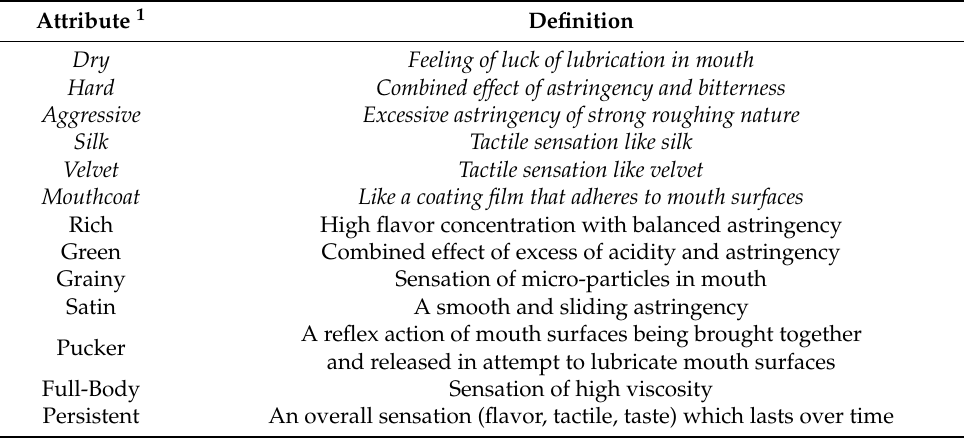
Table 1. Definitions of the sensory attributes presented in the Check-All-That-Apply (CATA) ques- tionnaire to consumers and trained assessors. All the terms were presented to the trained assessors in Rate-All-That-Apply (RATA)